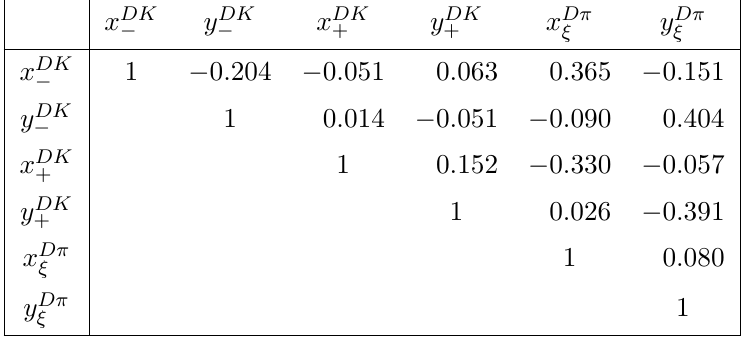
Table 4 . Statistical correlation matrix obtained for the combined Belle and Belle II data set.